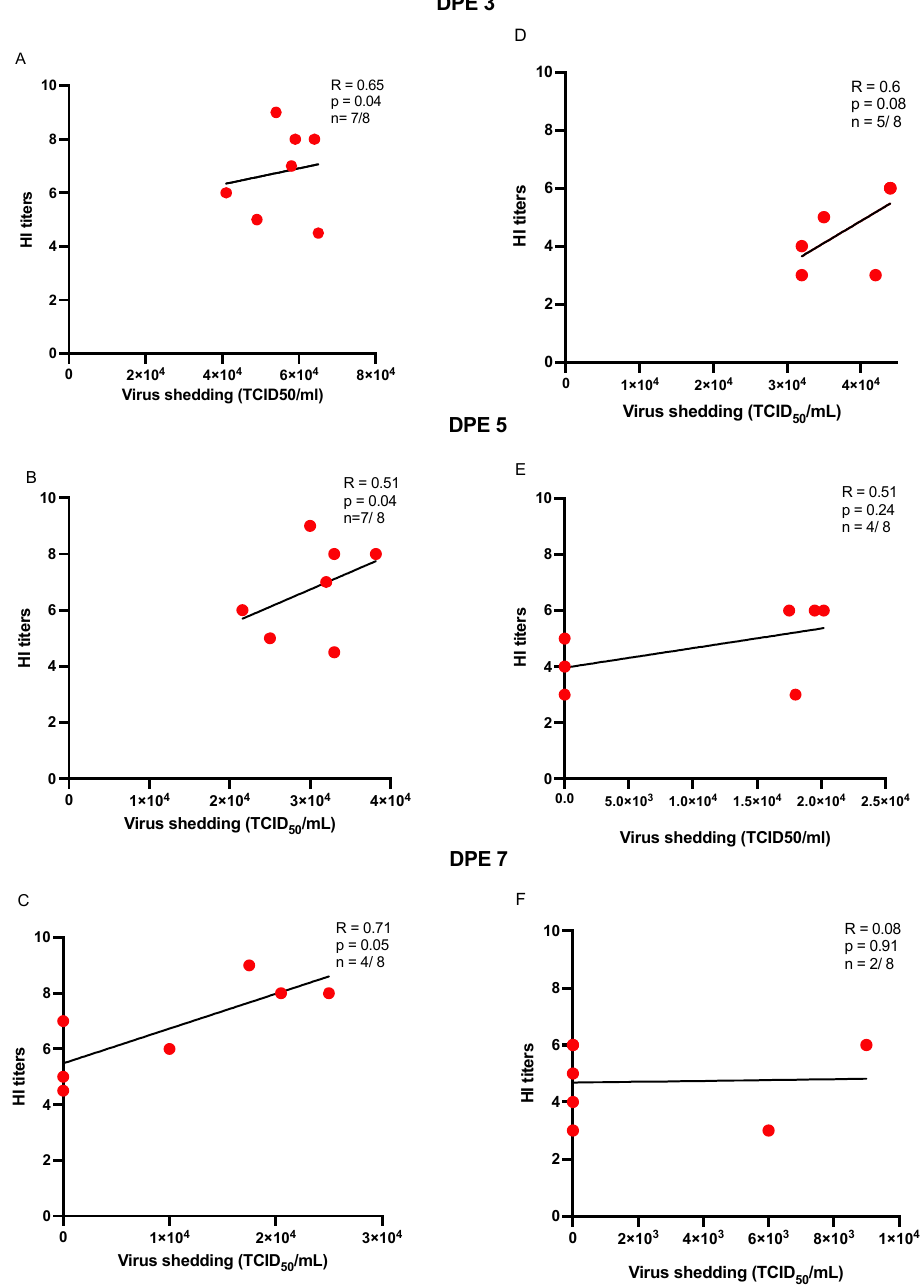
Figure 5. ( A – F ) Scatter plots illustrating the correlation of HI antibody titers and oral virus shedding in recipient chickens (expressed as TCID50/mL). Spearman’s correlation (R) was determined between oral virus shedding on days 3, 5, and 7 post-exposure (PE) with the HI titers (day 14 PE) in the H9N2-AIV-infected recipient chickens (n) of the aerosol ( A – C ) and direct inoculation ( D – F ) groups. The data points on the graph represent individual chickens that were deemed positive using TCID 50 assay (out of the total recipient chickens) at the above-mentioned time points of swab collection. Data were considered significant when * p < 0.05.